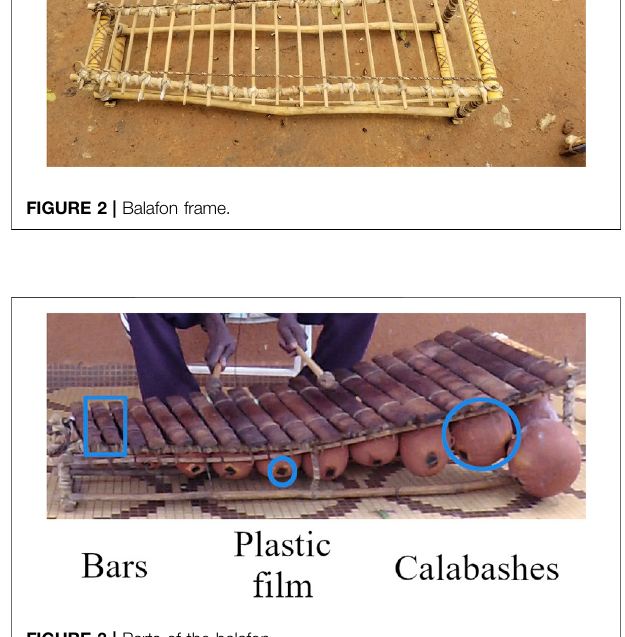
FIGURE 3 | Parts of the